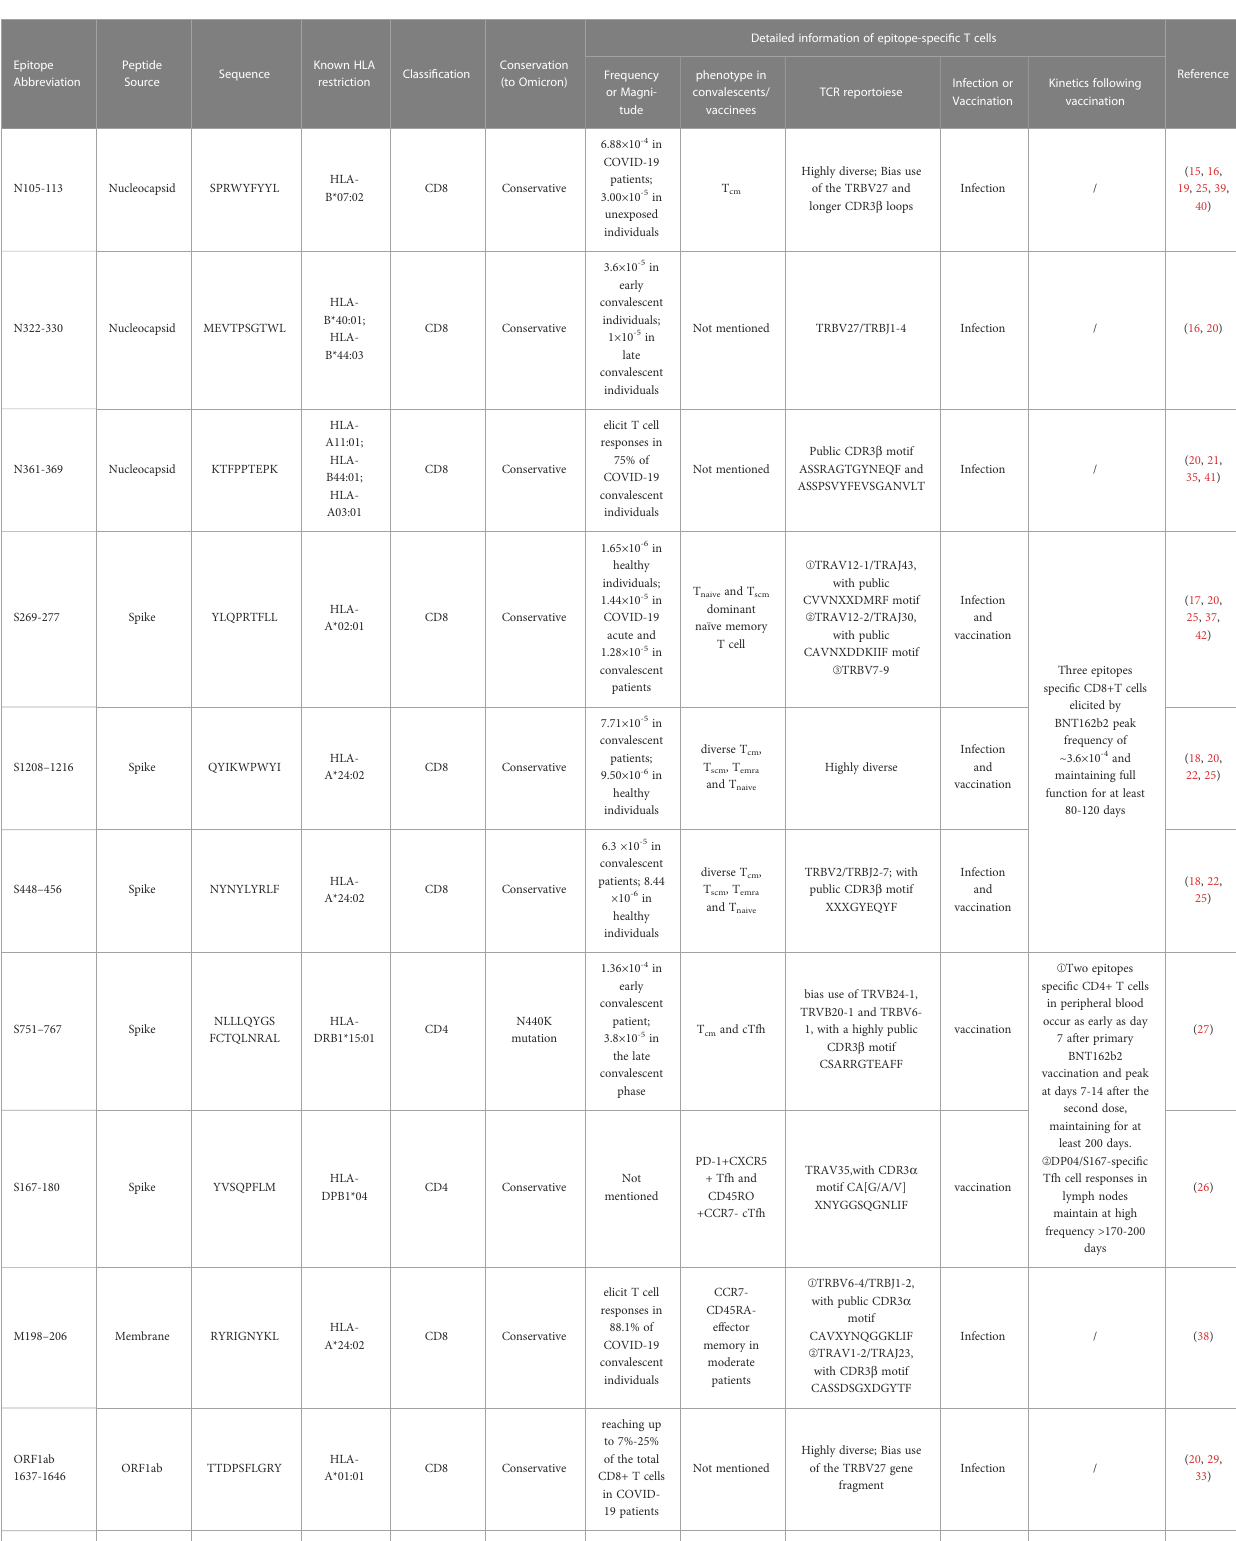
TABLE 1 Summary of SARS-CoV-2 immunodominant epitopes